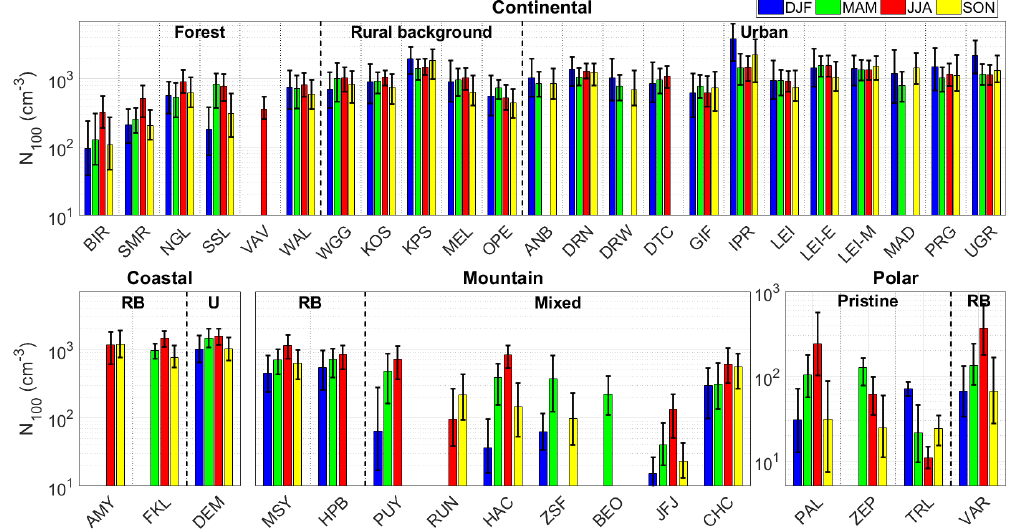
Figure 12. Seasonal statistics of N 100 , the particle number concentration in the range of 100–500nm, used as a proxy for potential CCN population. The bars represent the median of N 100 , and the lower and upper ends of the error bars represent the first and third quartiles of the data, respectively. Stations are sorted based on the classification reported in Table 1. The meaning of the abbreviations used for the footprint is the following: RB for rural background and U for urban.